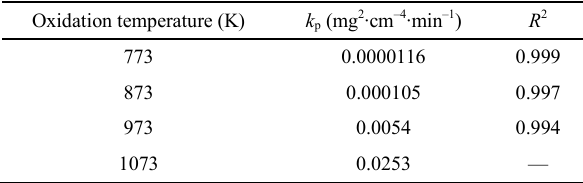
Calculated k p with corresponding R 2 (fit goodness) for various oxidation temperatures Oxidation temperature